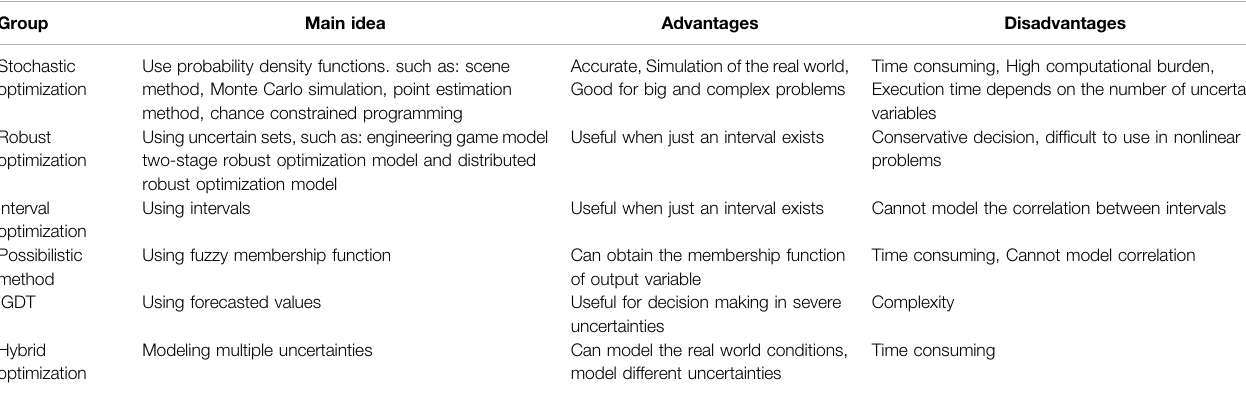
TABLE 3 | Summaries of uncertainty modeling